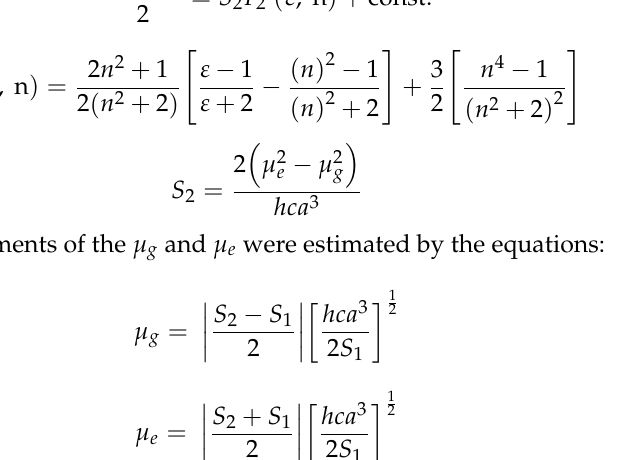
Figure 7. Absorbance spectra of compounds I – V in solid state at room temperature.